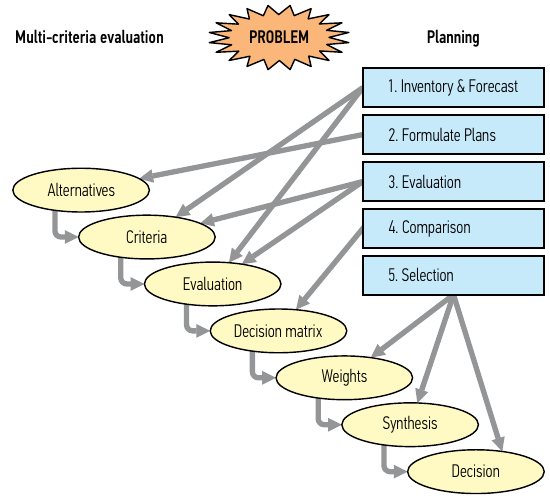
Fig. 1. The process of decision-making (Linkov et al.